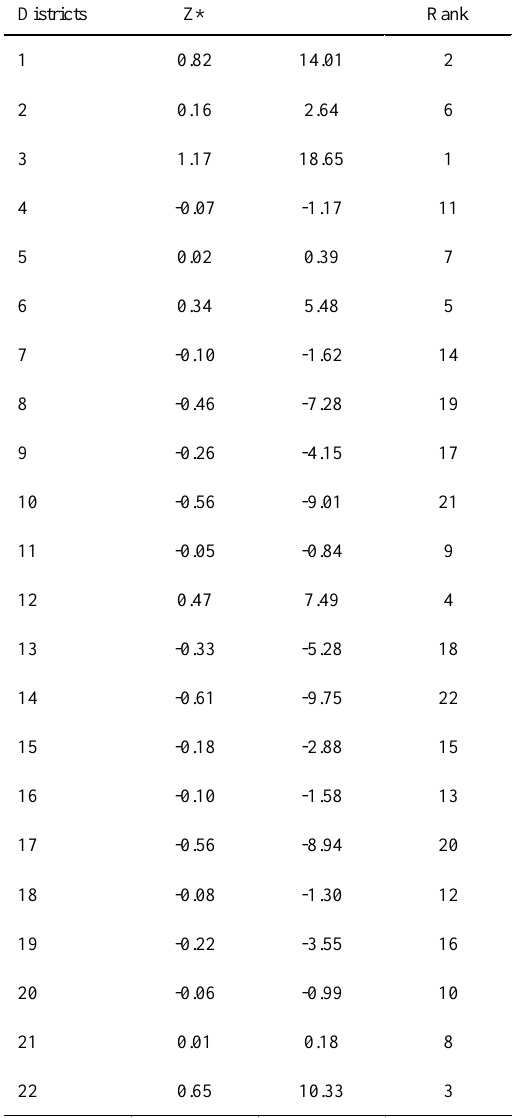
*z-score is also known as a standard